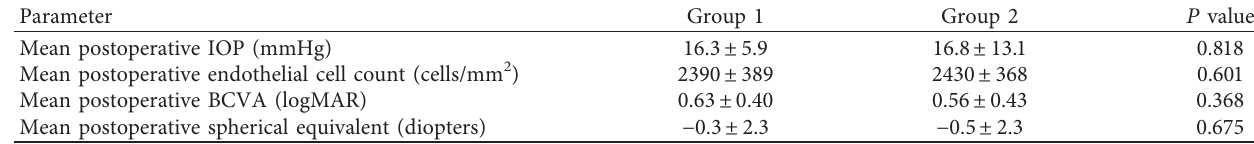
Table 2: Comparison of parameters between Groups 1 and 2.